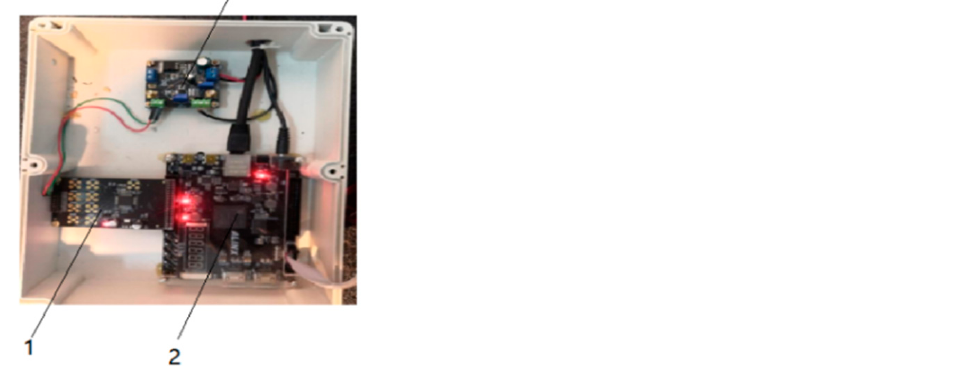
Figure 2. Hardware diagram of on-line monitoring system for grain impact test. 1—AD620 voltage amplifier, 2—FPGA AX7103, 3—AN706 Signal acquisition module.